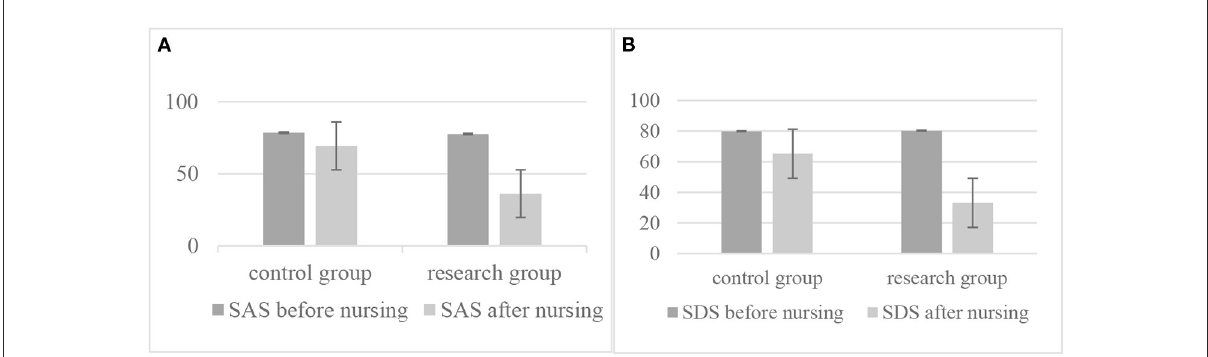
FIGURE1 Contrast of anxiety and depression in the two sets of patients before and after nursing: (A) The contrast of anxiety scale between control group and research group before and/or after nursing; (B) The contrast of depression scale between control group and research group before and/or after